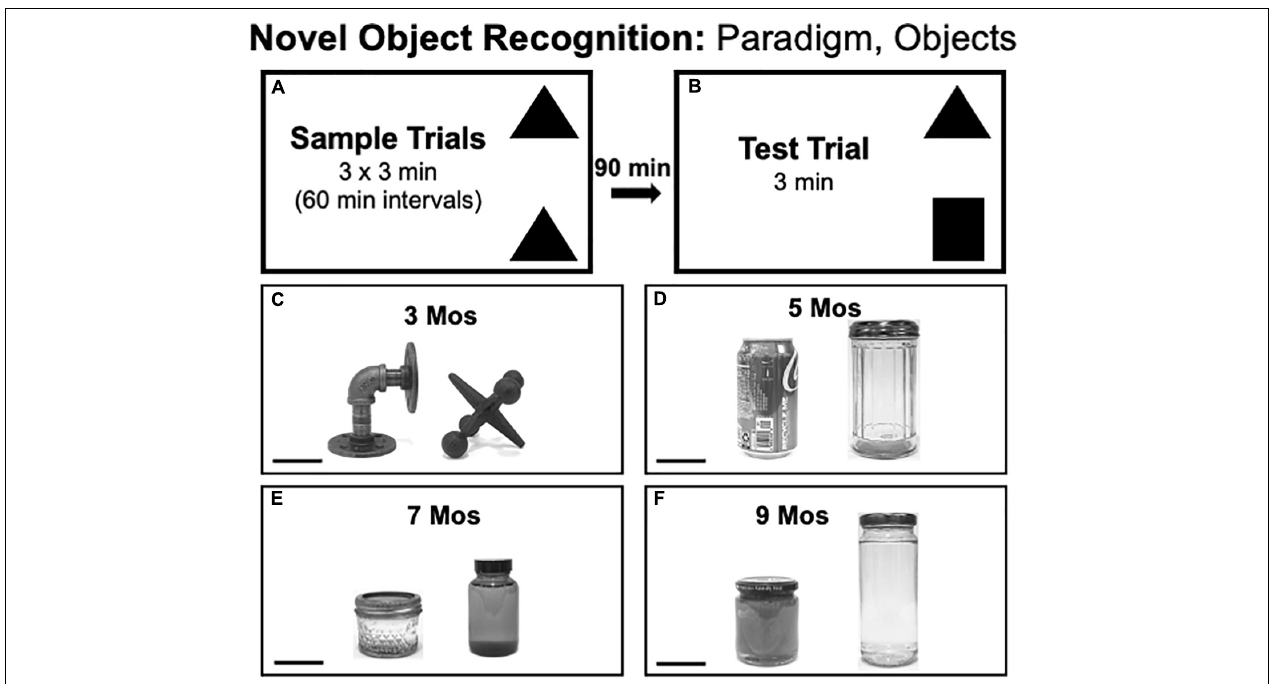
FIGURE 2 | (A,B) Schematic diagrams showing trial structure for the Novel Object Recognition paradigm. (C–F) Black and white photographs showing the items that were used as sample or novel objects for testing at each of the four ages evaluated [3, 5, 7, and 9 months (mos) of age]. The objects are displayed at a 45 degree angle relative to each other to provide spatial perspective. The objects used in testing at 3 mos of age (C) were made of cast iron. The objects used in testing at 5 mos of age (D) were made of aluminum (left) or glass (right). Both items used for testing at 7 (E) and 9 mos of age (F) were made of glass. Scale bars = 50 mm.